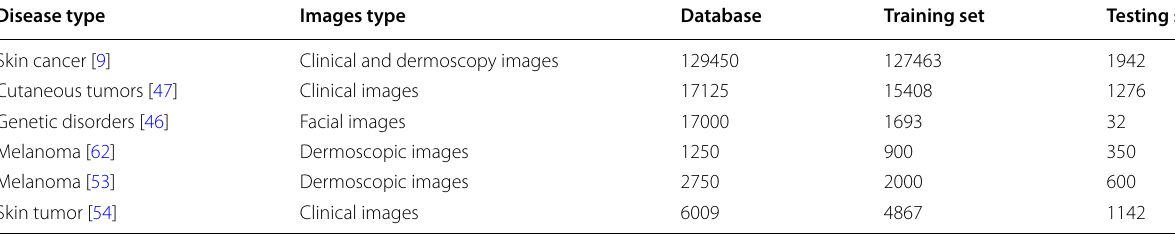
Table 2 Data size of selected deep learning projects Disease type